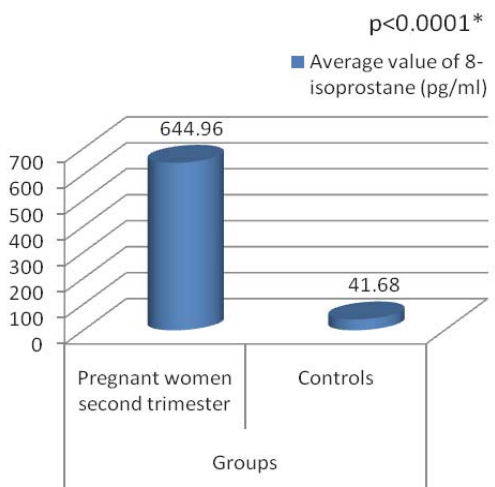
FIGURE 1. - 8 - isoprostane average values for pregnant women and control group